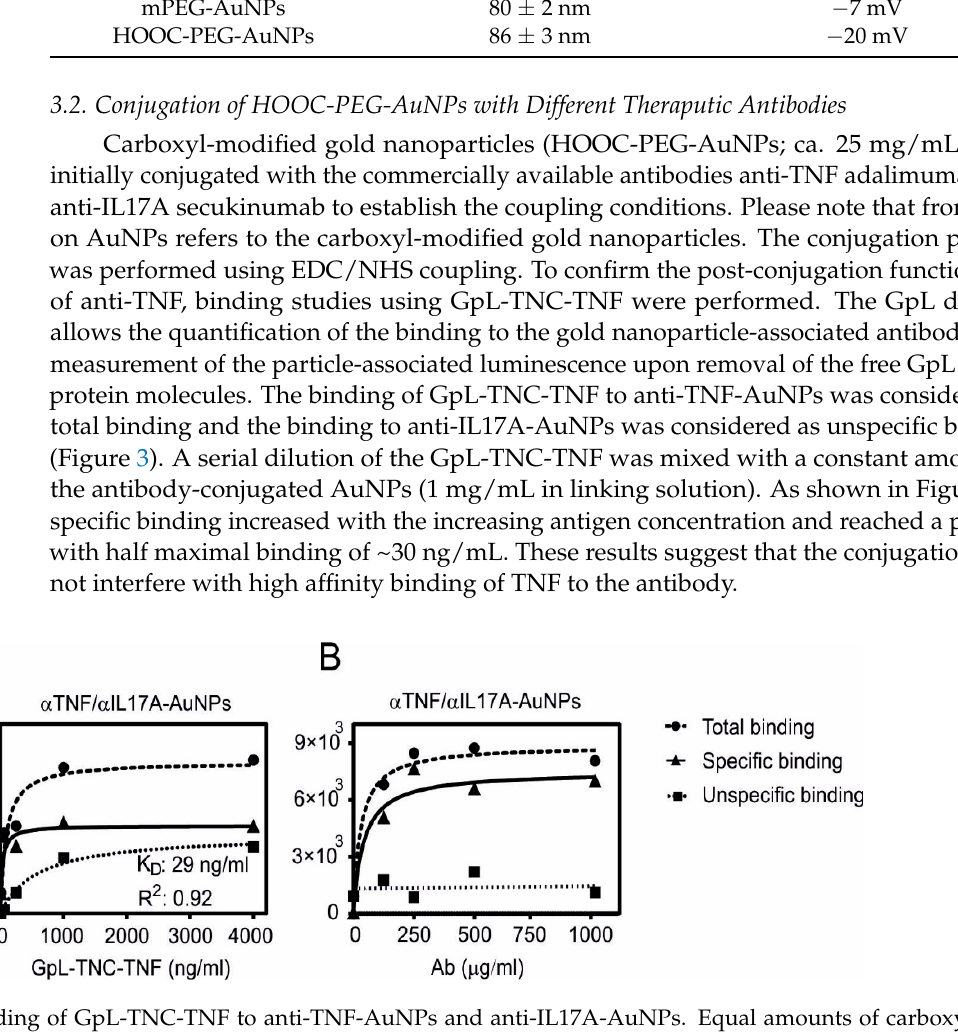
Figure 3. Specific binding of GpL-TNC-TNF to anti-TNF-AuNPs and anti-IL17A-AuNPs. Equal amounts of carboxyl- modified gold nanoparticles (AuNPs; 25 mg/mL) were conjugated with a constant concentration of anti-TNF or anti-IL17A (2 mg/mL). After removal of the excess unbound antibody molecules, the antibody-conjugated AuNPs were incubated with the indicated concentrations of the GpL-TNC-TNF fusion protein for an hour at 37 ◦ C ( A ). Alternatively, increasing concentrations of the two antibodies were used for gold nanoparticle conjugation and were then incubated with a fixed concentration (500 ng/mL) of GpL-TNF-TNC ( B ). After removal of unbound GpL-TNF-TNF molecules, the nonspecific binding values (derived of the anti-IL17A-AuNPs) were subtracted from the corresponding total binding values (derived of the anti-TNF-AuNPs) to obtain specific binding values that were fitted using non-linear regression to a single binding site interaction plot using GraphPad Prism5